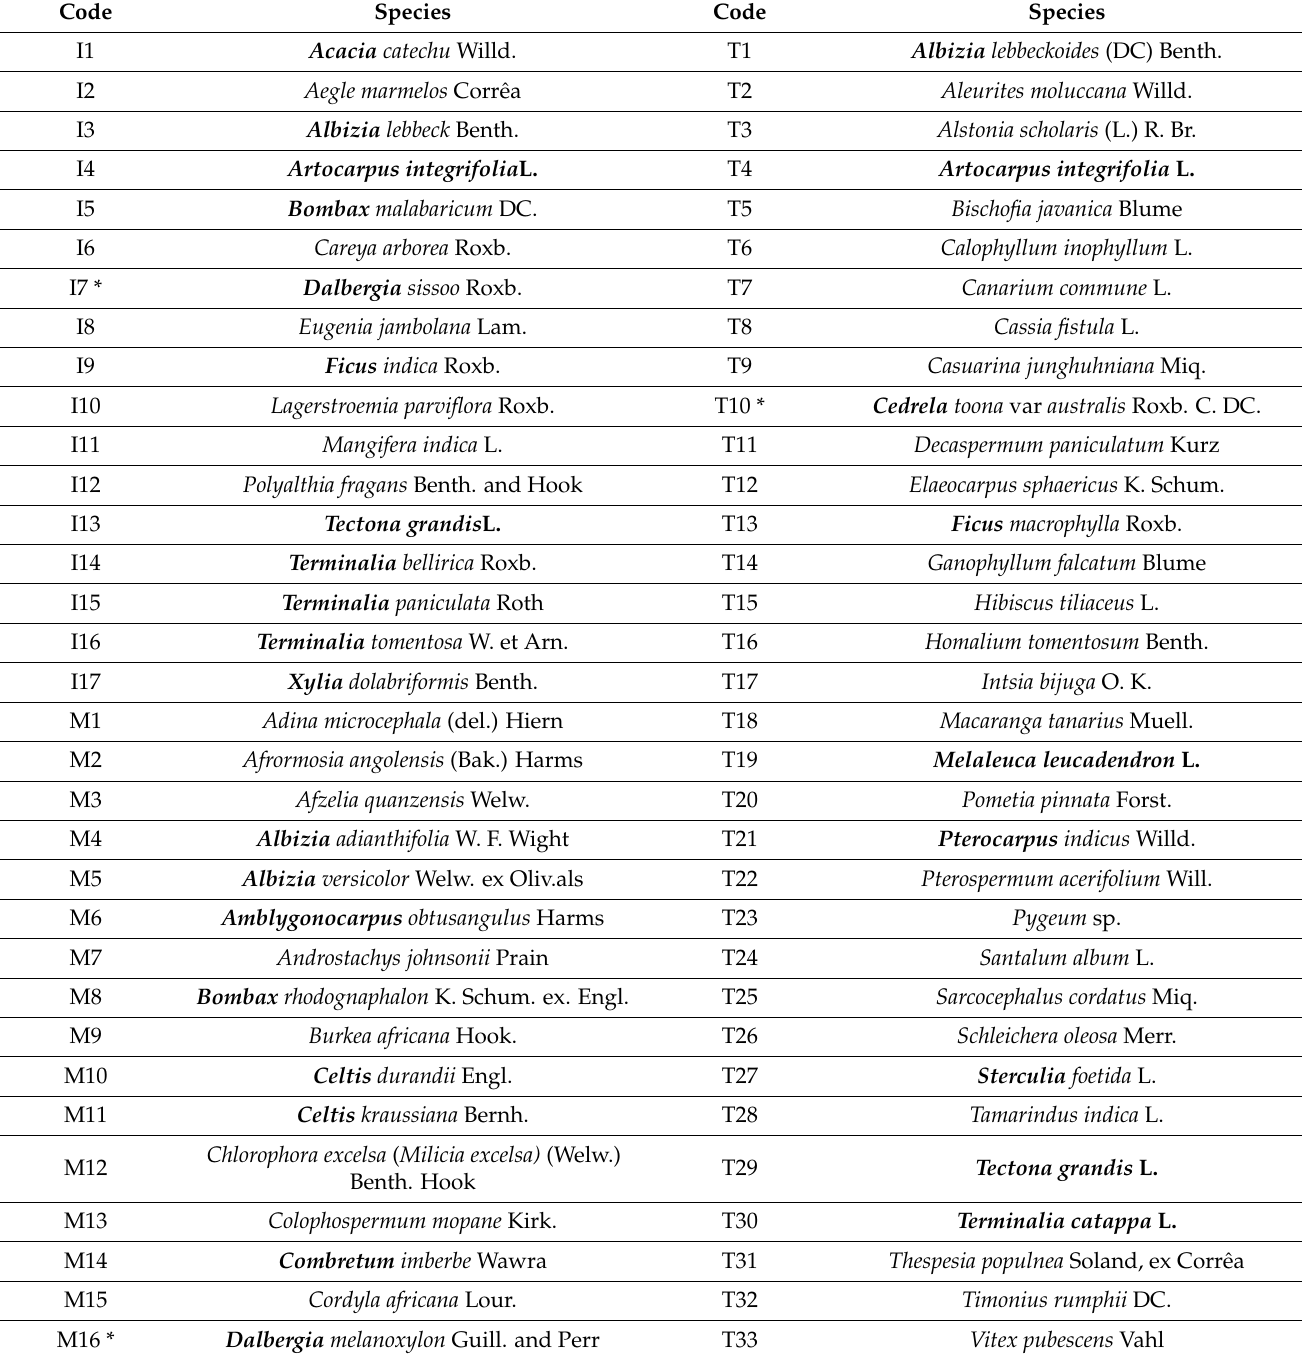
Table 1. List of the 98 studied tropical species by code according to each geographical provenance: India (I), Mozambique (M or N), and East Timor (T). The species with more than one geographical provenance and the genera with more than one species are marked in bold. Species marked with an asterisk are listed in the Convention on International Trade in Endangered Species of Wild Fauna and Flora (CITES) Appendix